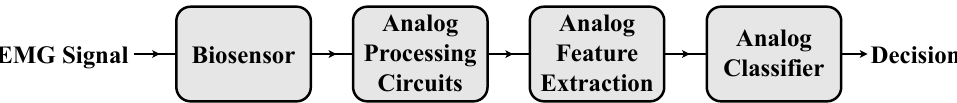
Figure 9. Top-level concept architecture for a fully analog hand gesture recognition system. It receives an EMG signal using a biosensor, which is then processed to enable the extraction of the classification features. Lastly, the final decision (in a digital format) is achieved via an analog classifier without the need for typical analog-to-digital